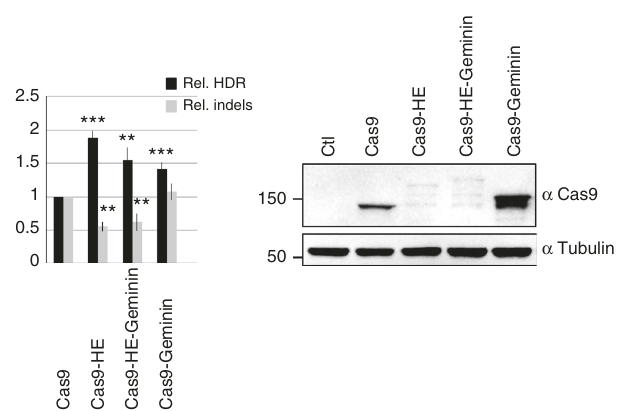
Fig. 3 Stimulation of transgene integration by Cas9 – HE and Cas9 – Geminin. Relative frequencies of HDR and indels induced by Cas9 or fusion of Cas9 to HE domain, Geminin degron, or both. Human HEK293 cells were transfected with the indicated Cas9 plasmids, T2 guide RNA, and GFP transgene donor with homology arms to the AAVS1 targeted locus. HDR- mediated transgene integration was measured by FACS analysis of GFP- positive cells, resulting from targeted GFP transgene integration. Indels at the cleavage site were measured by the T7E1 assay. The results are expressed as the mean of relative HDR or indel frequency calculated by normalizing every HDR or indel frequency by that induced by Cas9. Asterisks indicate that the difference is statistically signi fi cant when comparing Cas9 – HE, Cas9 – HE – Geminin, and Cas9 – Geminin to Cas9 in t - test (* P <0.05 or ** P <0.005). Data are from three independent experiments. Error bars indicate standard deviation. Relative expression levels of Cas9 and other fusions were analyzed by western blot with anti- Cas9 and control anti-tubulin antibodies. Protein extracts were obtained with lysis buffer containing 150 mM NaCl, which resulted in inef fi cient solubilization of Cas9 fusions with the HE domain compared to those